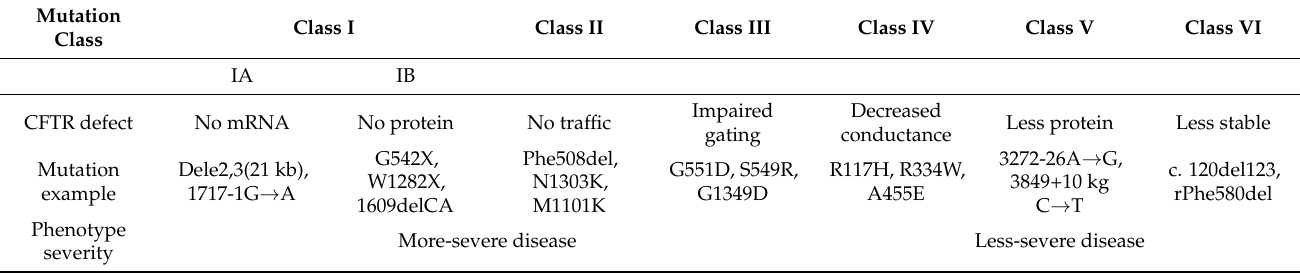
Table 1. Classification of CFTR mutations and phenotype